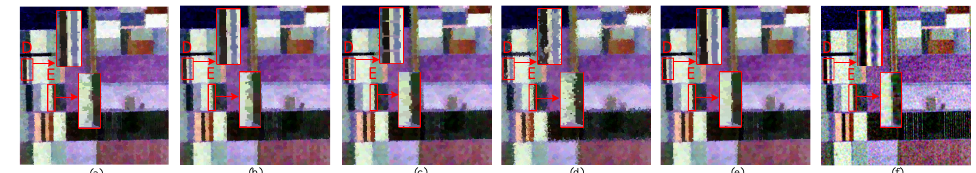
Figure 14. Enlarged results for region A of the AIRSAR data set. ( a ) POL-HLT. ( b ) WS. ( c ) HAWS. ( d ) HAGS. ( e ) The proposed HCI. ( f ) Pauli-RGB image. The HLT distance is adopted by the POL-HLT, which measures the similarity of two covariance matrices complying with the complex Wishart distribution. To eliminate the two- sided (nonsymmetric) effect when the distance between two pixels is measured, both the revised HLT distance and the HLT distance should be calculated, which severely increases the computational burden. The USE of POL-HLT also performs unsatisfactorily, which is on average 7% higher than that of the proposed HCI. Moreover, Figure 15 shows the inferior regularity of POL-HLT in both the homogeneous and the heterogeneous regions, especially compared with that of the proposed HCI. Figure 15c is zoomed in to show the superpixels in blue rectangles in Figure 15a,b. Generated superpixels of the proposed HCI are more regular, which can be observed as more compact and uniform superpixels based on hexagons in the homogeneous regions. However, the superpixels obtained by POL-HLT are seriously disturbed, the sizes are different, and it is even difficult to distinguish different superpixel blocks. It is an adverse effect on the performance of subsequent PolSAR image interpretation tasks.